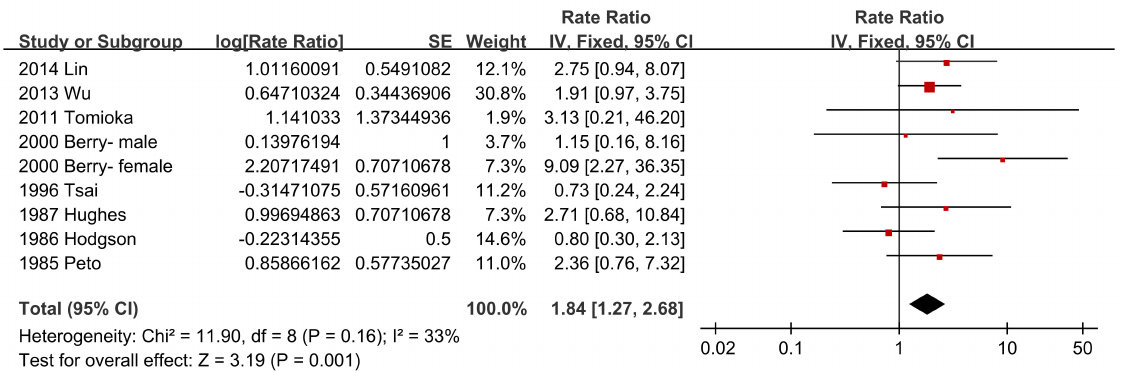
Figure 8. Subgroup analysis of SMRs of esophageal cancer based on sex.